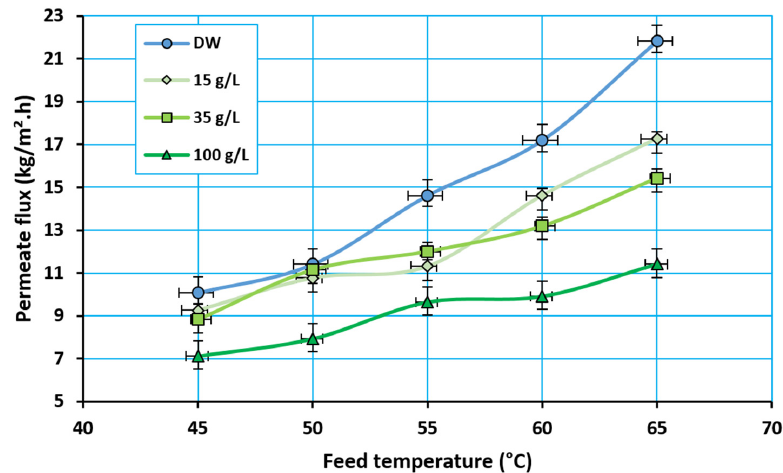
Figure 4. Influence of the hot feed temperature on the permeate flux at various concentrations and a feed flow rate of 1.07 L/min.